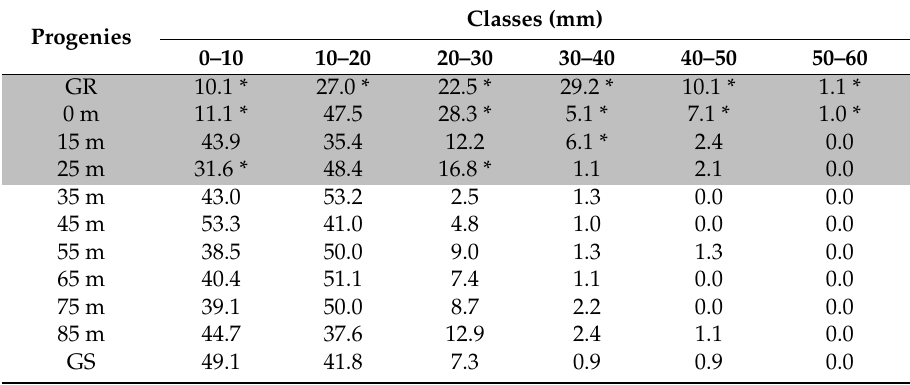
Table 1. Relative frequency (%) distribution of plumule length in progenies of pollen receptor plants (spaced from 0 to 85 m from the glyphosate-resistant plants as the source of pollen), glyphosate-resistant plants (GR, positive control), and isolated glyphosate-susceptible plants (GS, negative control). Shaded rows indicate significantly different distributions compared to GS (chi-squared tests, p < 0.05), and frequencies marked by asterisk are significantly different from those recorded in GS ( z -test, p < 0.05).